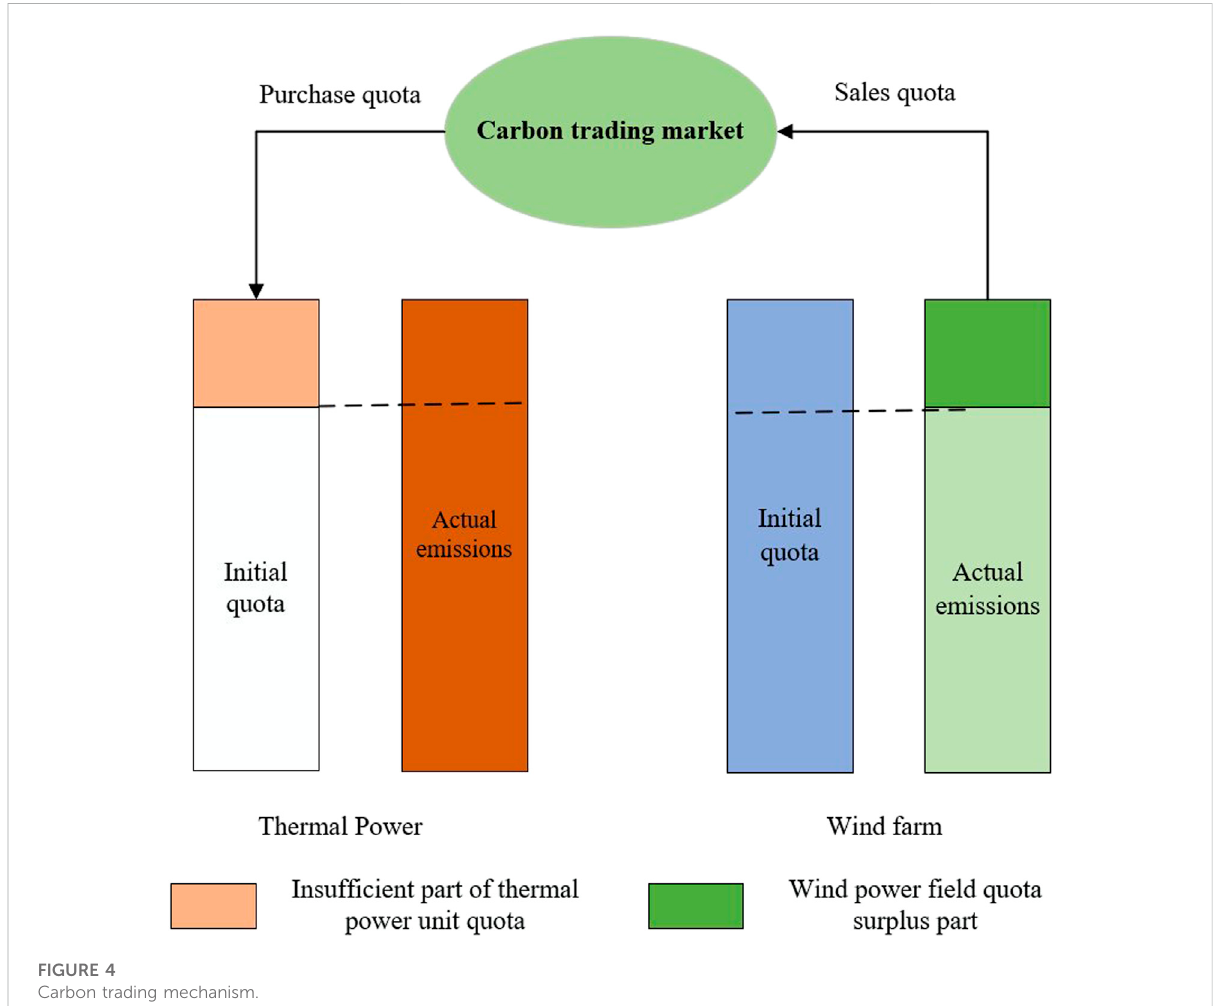
FIGURE 4 Carbon trading